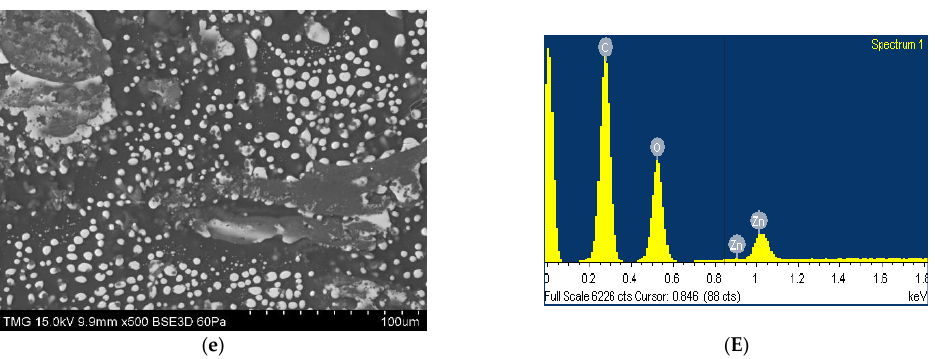
Figure 11. EDX spectra ( A – E ) and SEM images of ( a ) starch/polyvinyl alcohol/citric acid/glycerol (SPGC), and starch/polyvinyl alcohol/citric acid/glycerol/nZnO films, ( b ) 0.2 g nZnO (S1), ( c ) 0.25 g nZnO (S2), ( d ) 0.3 g nZnO (S3), ( e ) 0.35 g nZnO (S4).